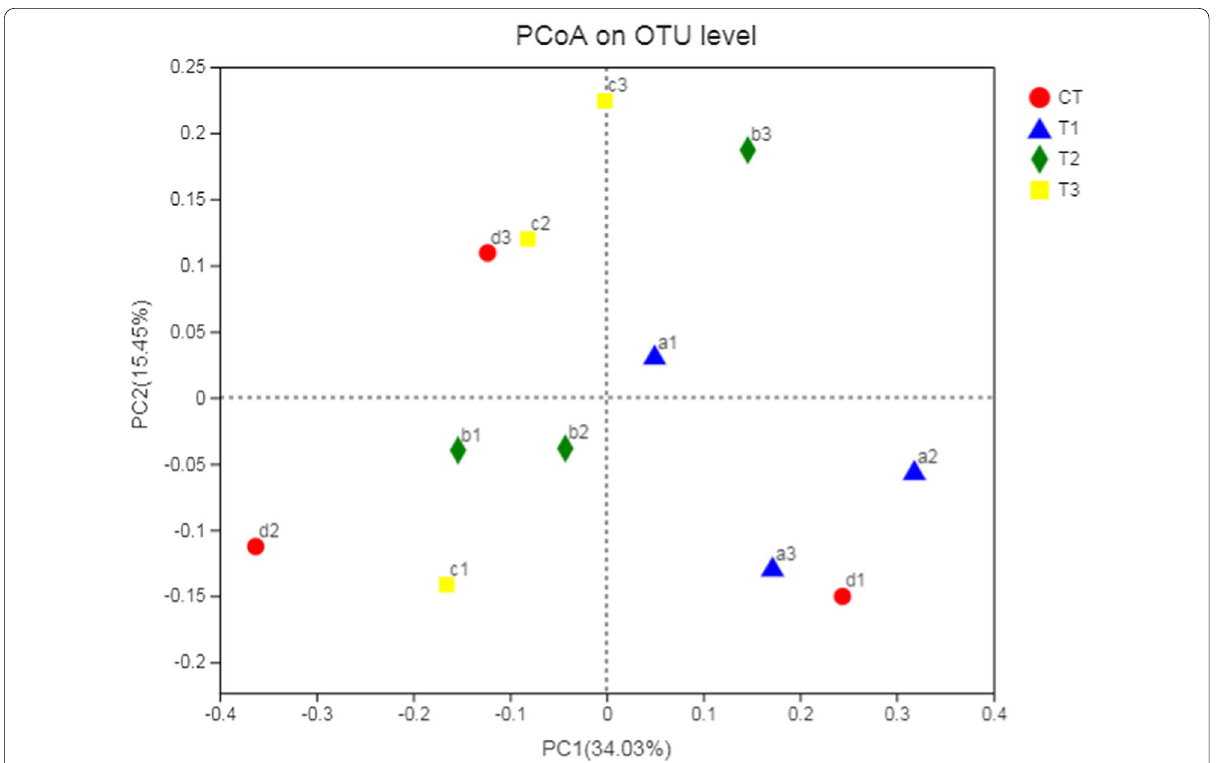
Fig. 1 PCoA analysis of bacterial population in the rumen of water buffaloes. CT (a1,a2,a3), T1 (b1,b2,b3), T2 (c1,c2,c3), T3